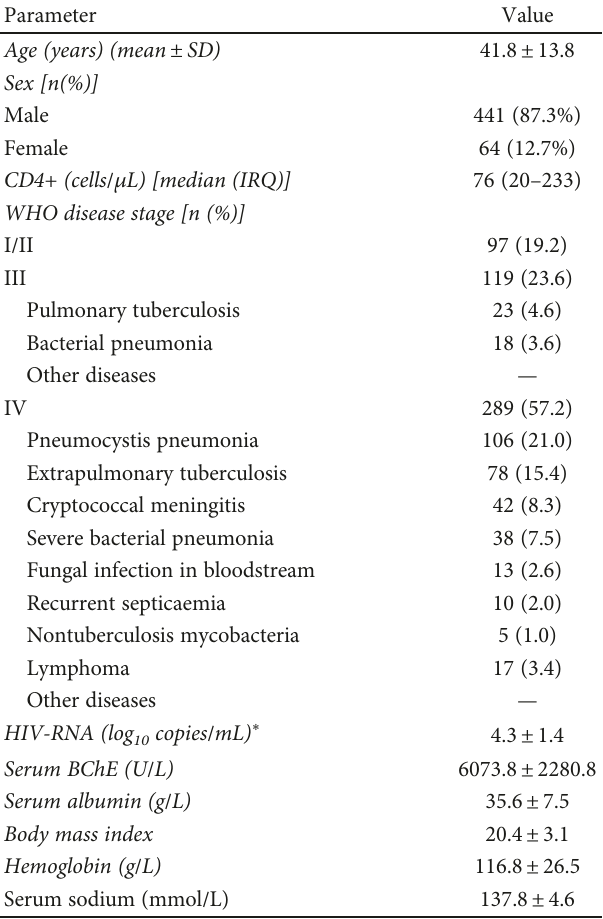
Table 1: Patient basic characteristics ( n = 505